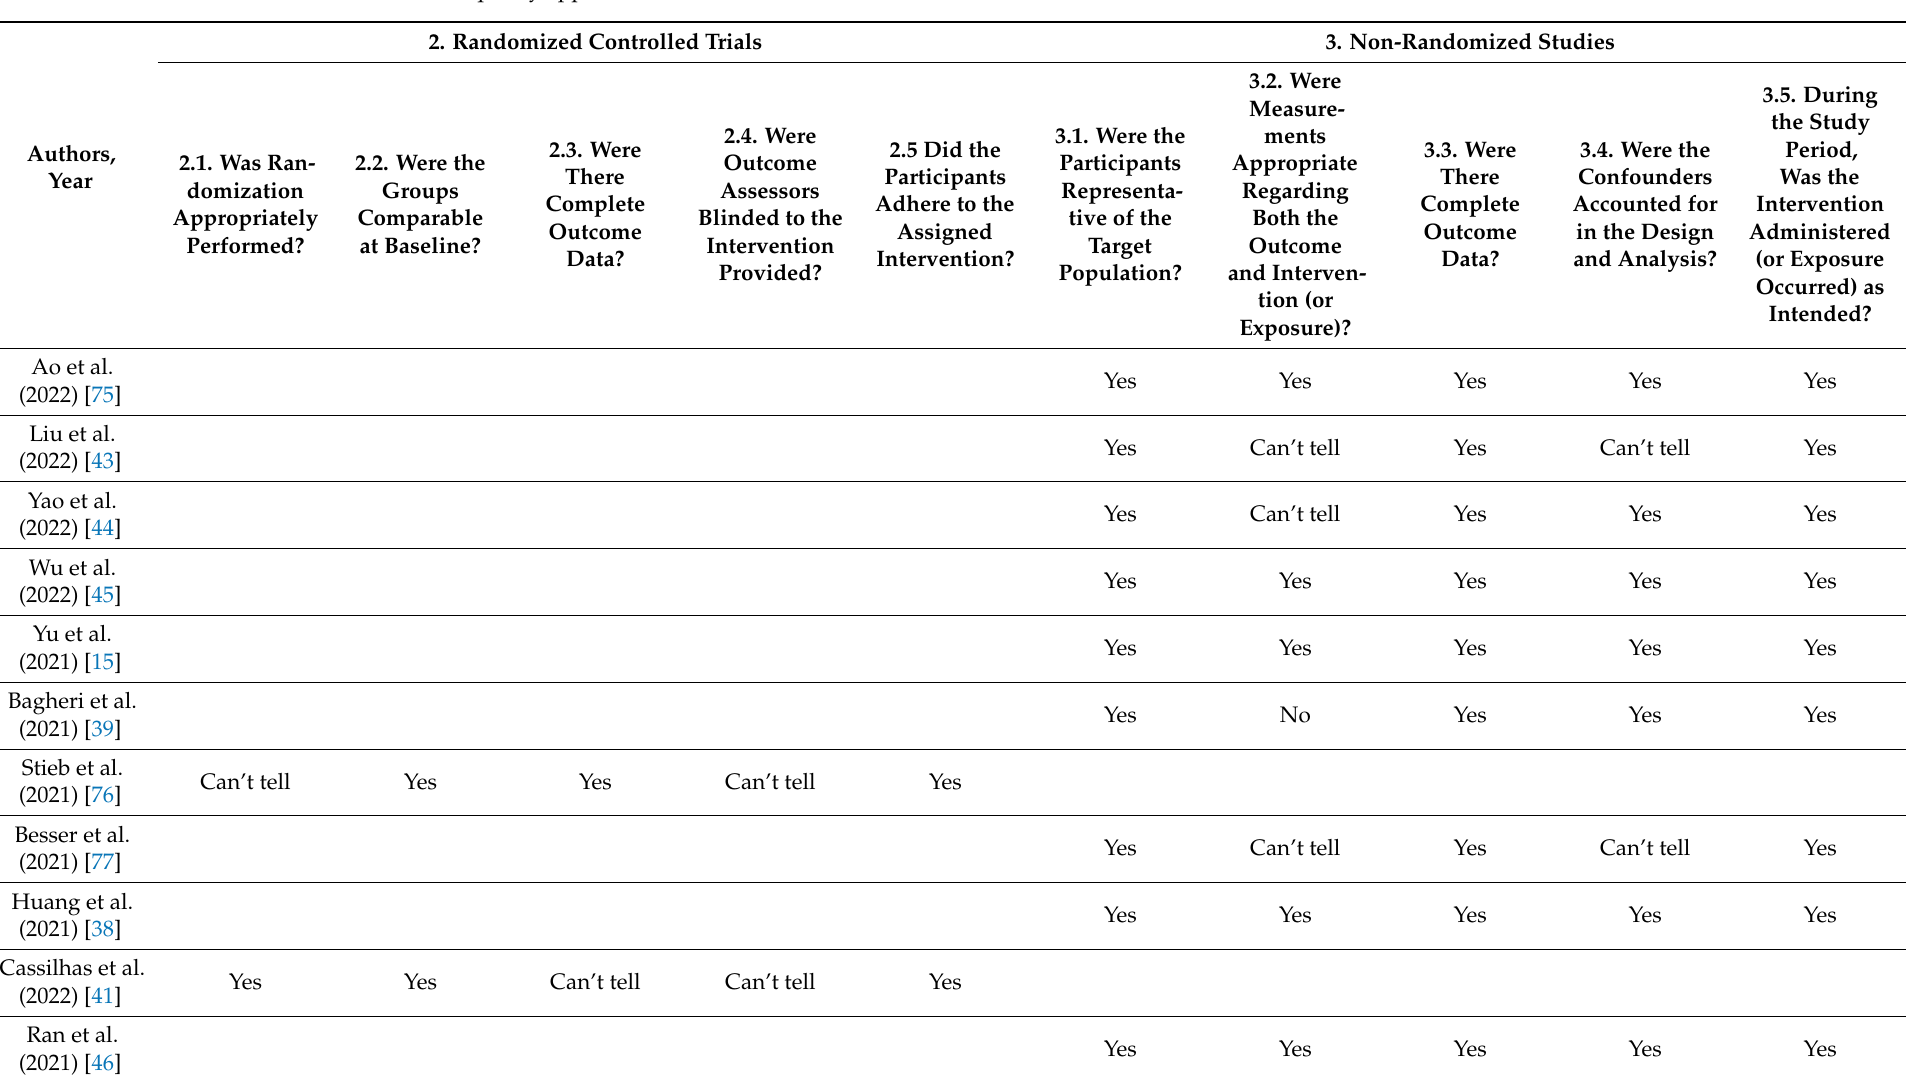
Table 7. MMAT quality appraisal results *